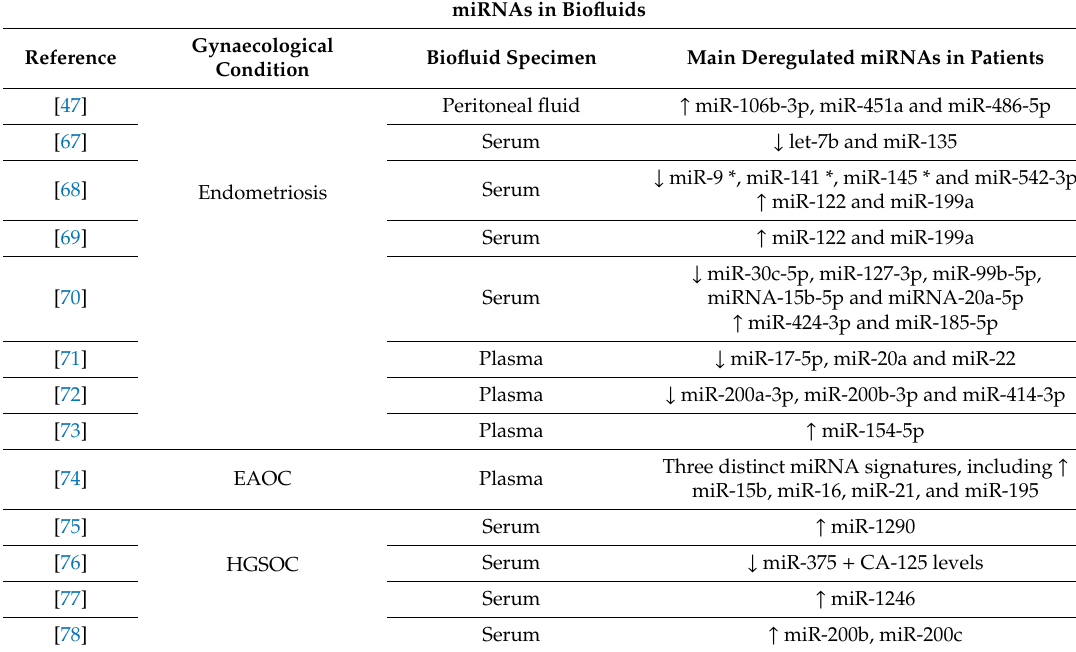
Table 2. Deregulated miRNAs in selected studies considering distinct biofluids from patients with endometriosis, EAOC or HGSOC compared to control